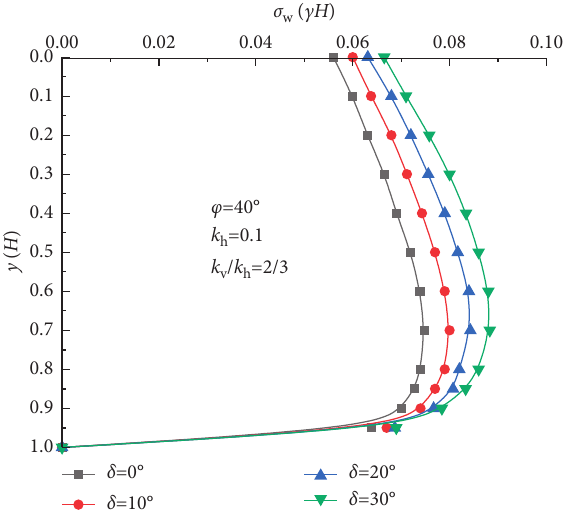
Figure 10: Influence of δ on seismic active earth pressure distribution.